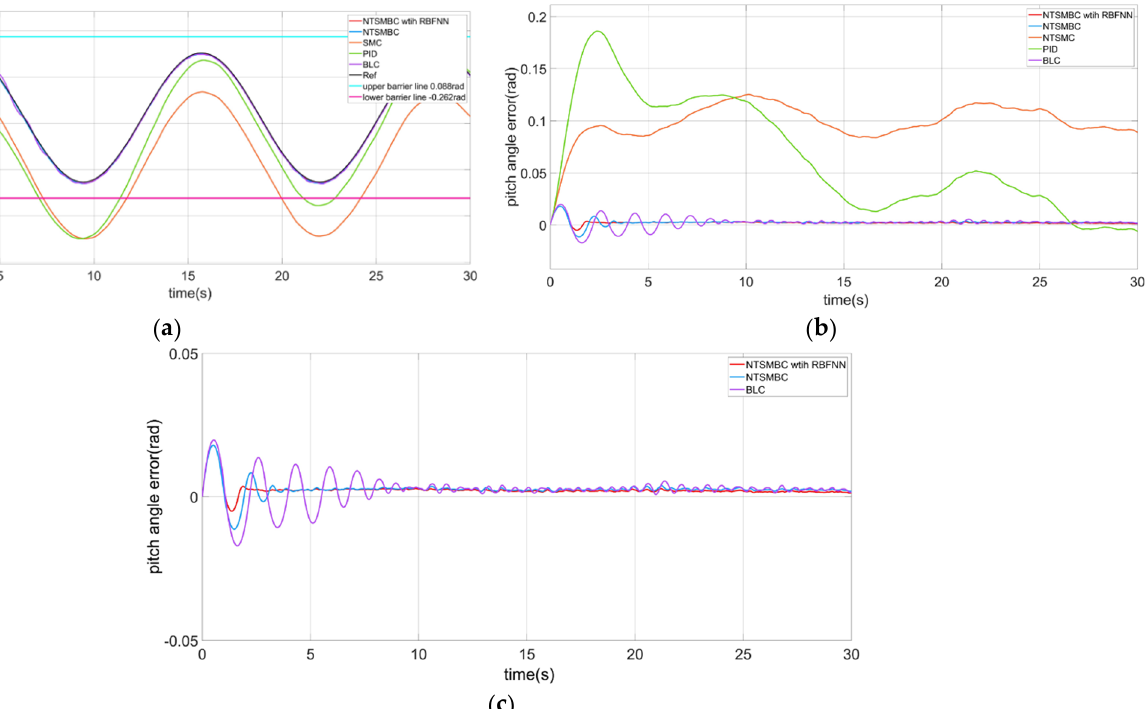
Figure 11. The pitch angle control in presence of the random lumped disturbance. ( a ) The pitch angle control results of the four control methods with random lumped disturbance. ( b ) The pitch angle control error with random lumped disturbance. ( c ) Local magnification.